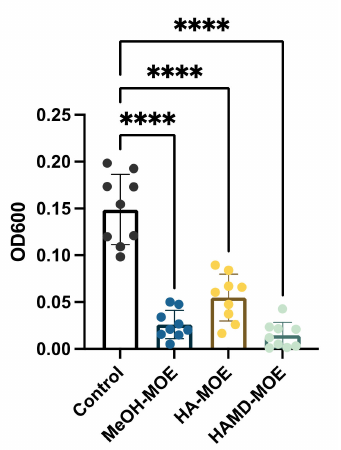
Figure 5. Effects of MOEs on amylovoran production. Amylovoran was measured by OD 600 . Data are the mean of 3 measurements performed on three different shoots (mean +/ − standard deviation), and values are represented as a percentage; **** p -values <